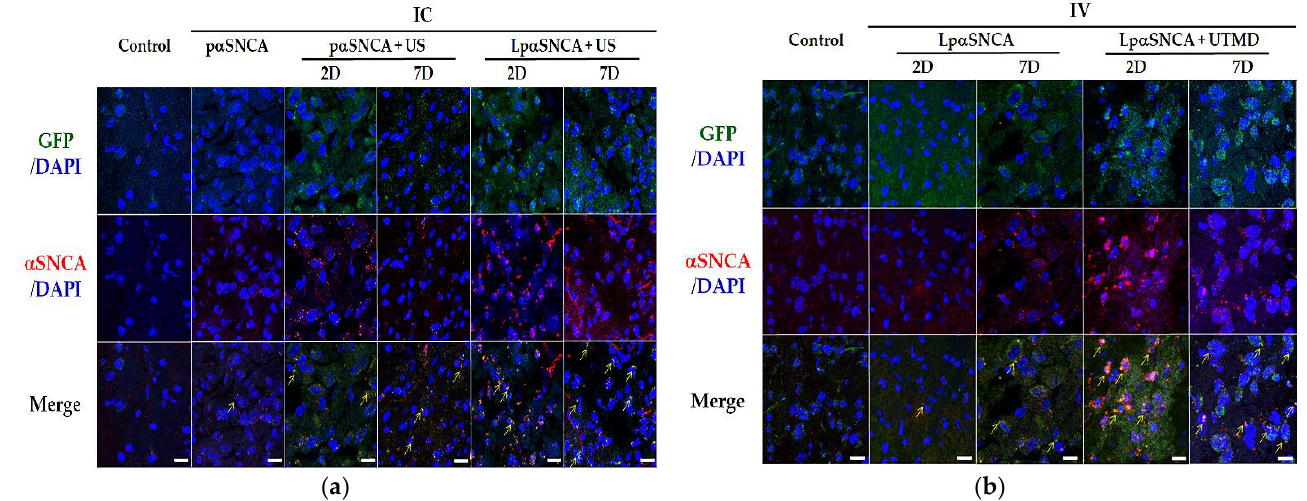
Figure 4. Representative intracellular aggregation of mice following ( a ) IC with naked p α SNCA (10 μ g), Lp α SNCA (10 μ g pDNA) or Lp α SNCA (10 μ g pDNA) +/− US expressed at day 2 and day 7, and ( b ) IV with Lp α DNA (60 μ g pDNA) +/− UTMD expressed on day 2 and day 7. n ≥ 3 for each group. IC = intracerebral; IV = intravenous; US = focused ultrasound; UTMD = focused ultrasound-targeted microbubble destruction; Lp α SNCA = liposomal plasmid α -synuclein; D = day. Arrows indicate aggregates. Scale bars = 20 μ m.